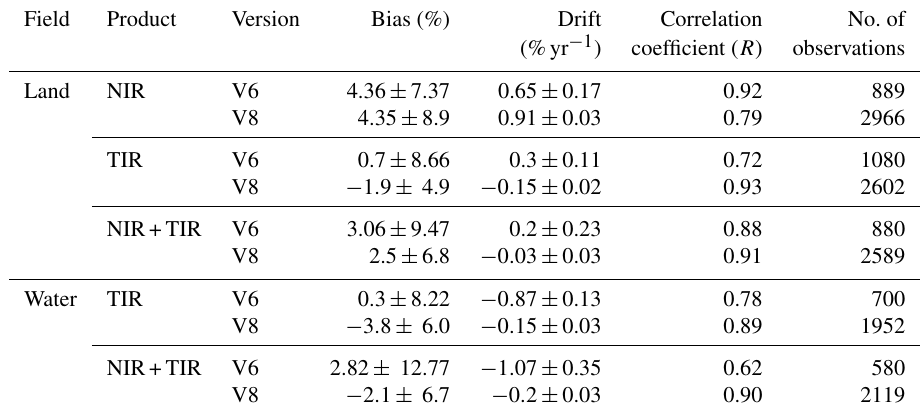
Table 2. Comparison between results presented in Buchholz2017 for MOPITT V6 data for the Eureka NDACC FTIR between 2006 and 2014, with results presented in this study for MOPITT V8 with Eureka NDACC FTIR data between 2006 and 2019.